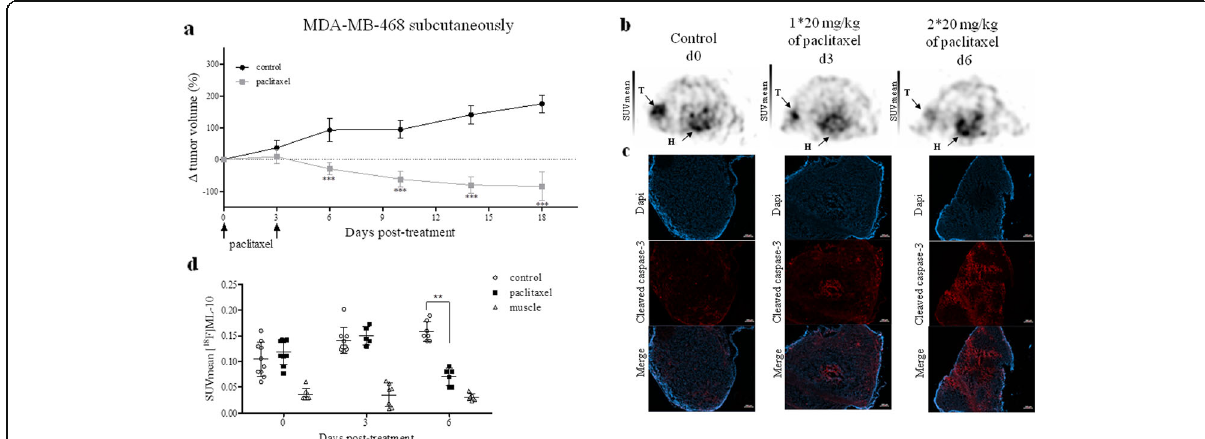
Fig. 8 Evaluation of early response by [ 18 F]ML-10 PET imaging on subcutaneously model. a Evaluation of tumor volume after two i.v. injections of paclitaxel (20 mg/kg) at a 72-h interval. Data are represented as mean ± SD. Compared to control, *** p < 0.001 (Mann-Whitney test). b Images of [ 18 F]ML-10 PET of representative MDA-MB-468 subcutaneous xenograft model performed and 72-h post-treatment. T represented tumor and H represented heart. c Representative image of cleaved caspase of tumor tissues. d [ 18 F]ML-10 uptake expressed as SUVmean in tumor control, tumor treated, and muscle at day 0, day 3, and day 6. Compared to control, *** p < 0.001 (Mann-Whitney